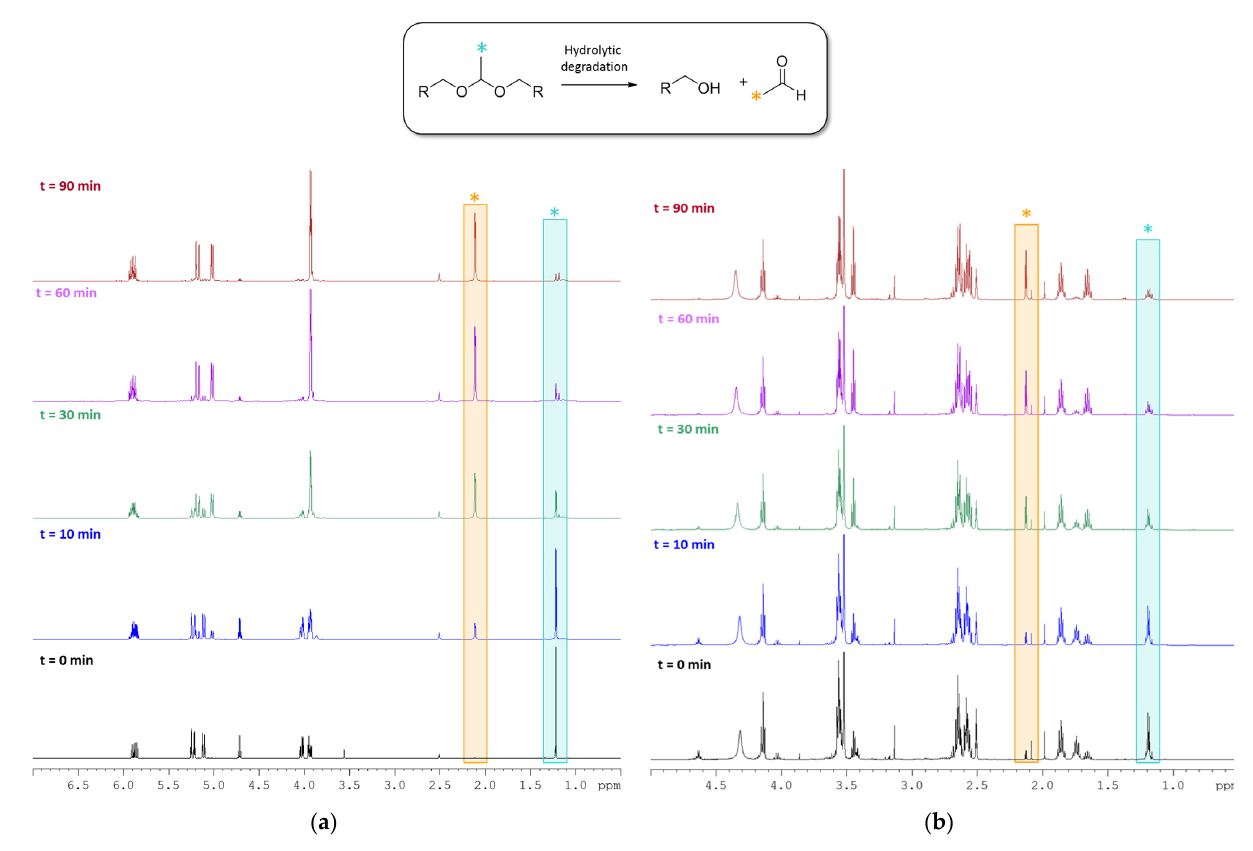
Figure 4. 1 H ‐ NMR studies of the hydrolytic degradation of ( a ) B monomer and ( b ) co ‐ p(CAR 50 B 50 ) with time.